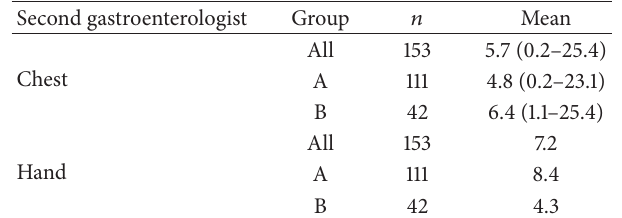
Table 5: Second gastroenterologist mean radiation doses ( 𝜇 Gy) for groups A and B per ERCP procedure. The range is in parenthesis.